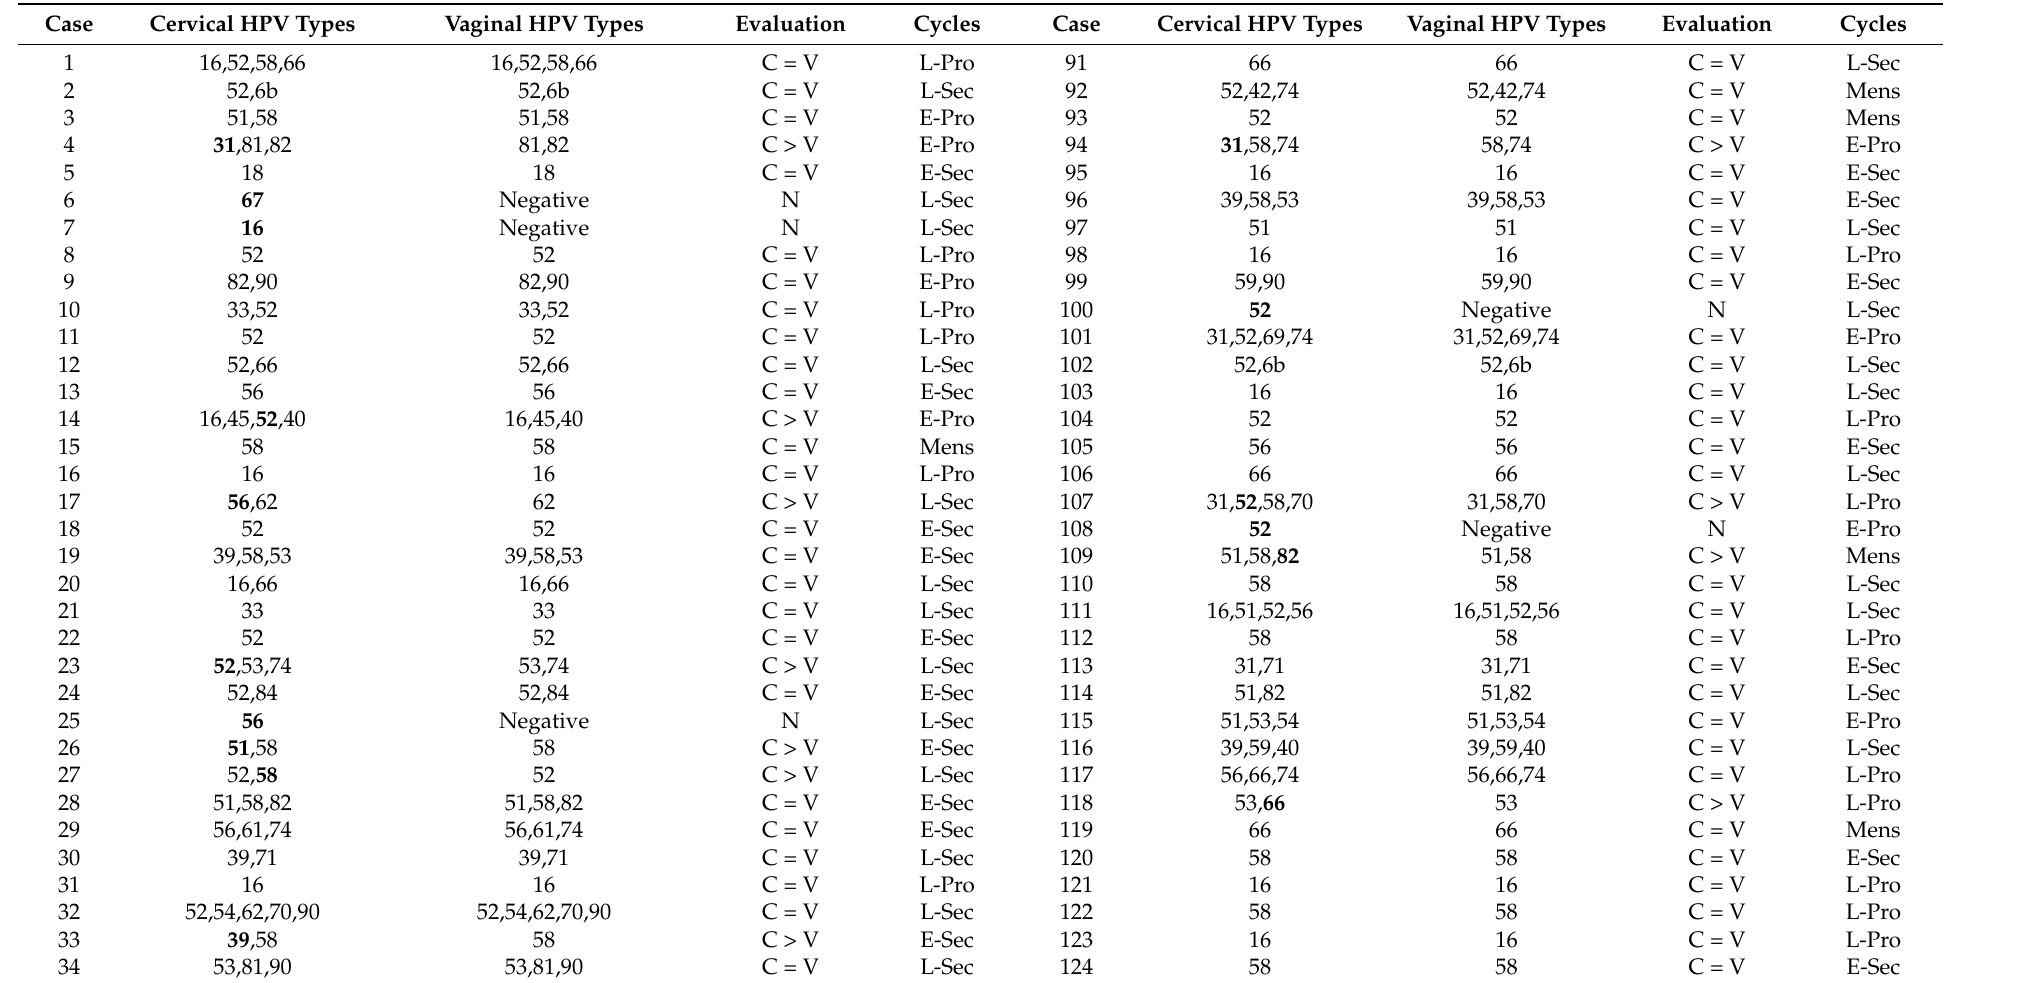
Table 1. Accumulation of exfoliated cells and menstrual cycle in 180